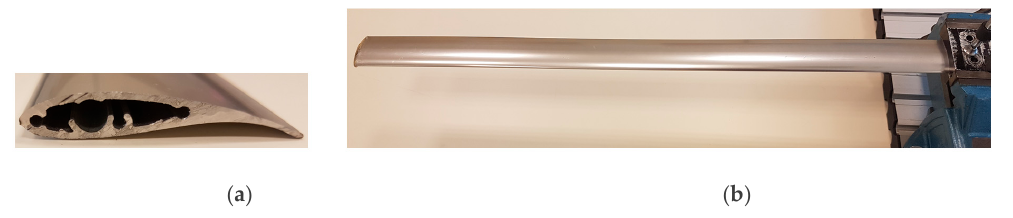
Figure 1. Photos of elastic blade structure ( a ) front view, ( b ) longitudinal view.